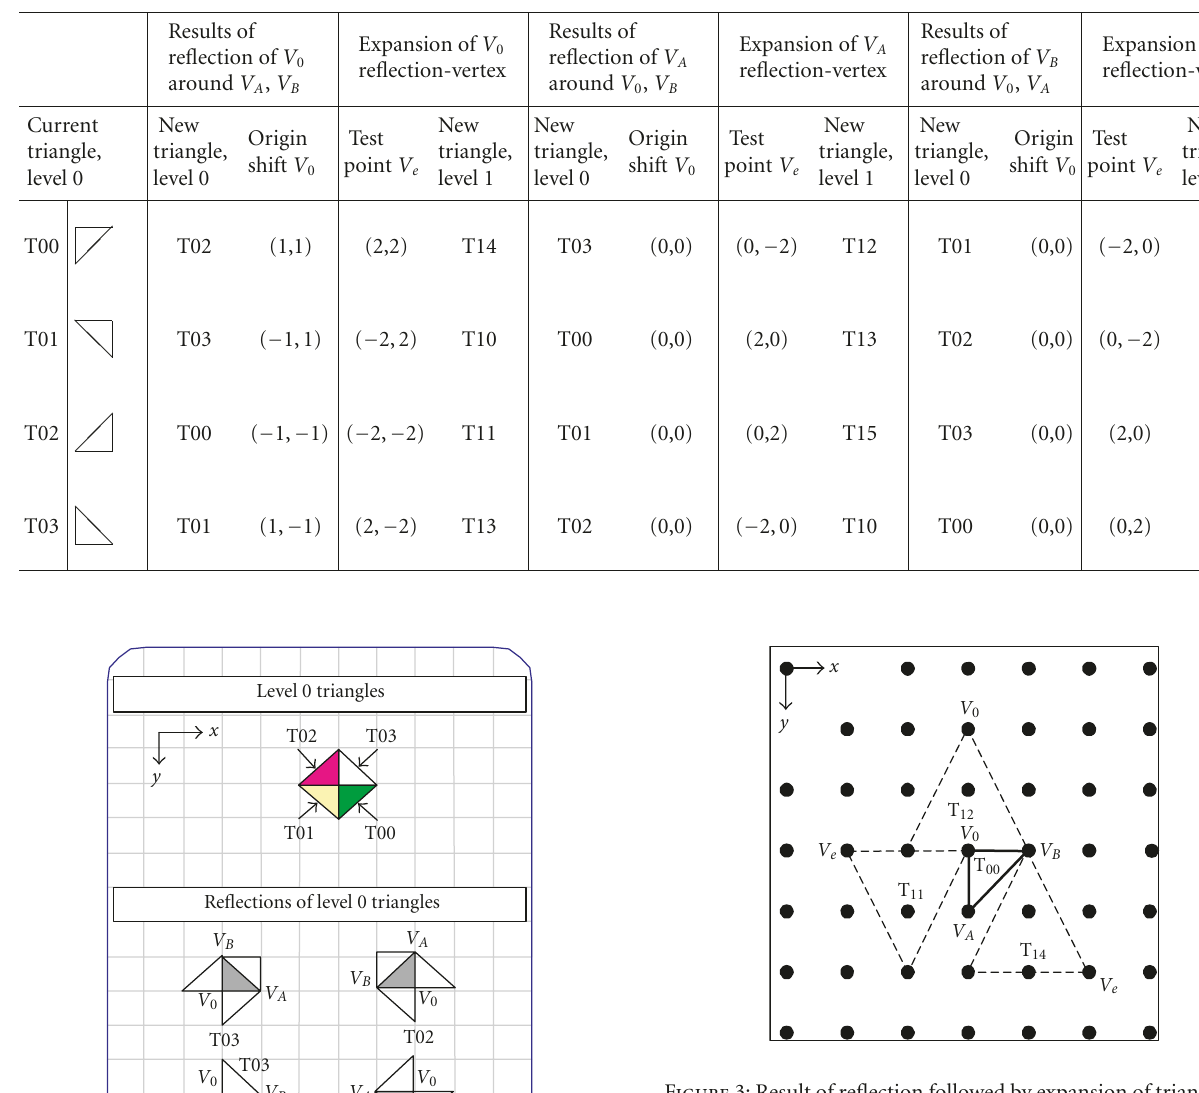
Table 1: Possible reflections and expansions for Level 0 triangles.